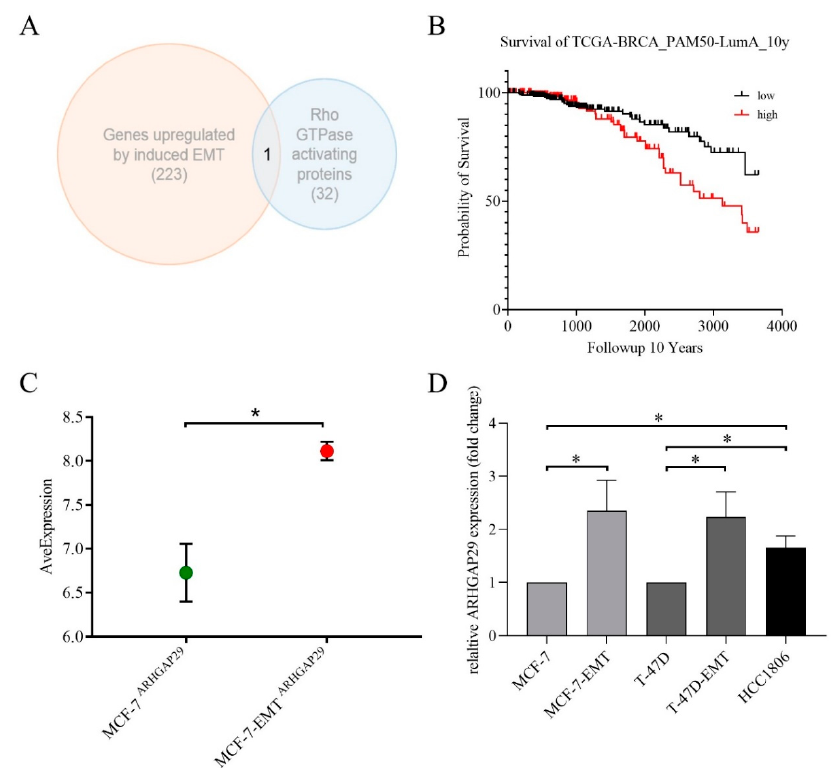
Figure 1. ( A ) Schematic representation of the overlap of microarray data of 223 genes upregulated by induced epithelial–mesenchymal transition (EMT) and 32 considered Rho GTPase-activating proteins. Microarray data from Ziegler et al. [22] were re-analyzed to show the upregulated expression of selected genes. Gene expression data of MCF-7 wild-type cells and mesenchymal-transformed MCF-7-EMT cells were compared. Among the genes examined were 32 genes that had previously been recognized as Rho GTPase-activating proteins. EMT-induced upregulation in MCF-7-EMT cells was found in 223 genes in comparison to MCF-7 wild-type cells. Only the Rho GTPase-activating protein 29 (ARHGAP29) was found to overlap. The relative change in expression (FC, fold change) of genes under consideration was 1.0–4.53. ( B ) Kaplan-Meier survival analysis of the luminal A breast cancer subtype (Threshold = 8 FPKM; ARHGAP29 low n = 271; ARHGAP29 high n = 209; Statistical test: Log-rank (Mantel-Cox) test; p = 0.0141). ( C ) Evidence of the significantly increased basal expression of ARHGAP29 in MCF-7-EMT cells was found. Basal expression (average expression) of ARHGAP29 in the cell lines MCF-7- and MCF-7-EMT was found. Microarray data from Ziegler et al., 2014 comparing the gene expression of MCF-7 wild-type cells and mesenchymal-transformed MCF-7-EMT cells were examined to investigate ARHGAP29 gene expression. ( D ) Expression of ARHGAP29 in MCF-7, MCF-7-EMT, T-47D, T-47D-EMT, and HCC1806 breast cancer cells. Expression of ARHGAP29 was analyzed by quantitative real-time PCR and normalized to GAPDH expression using at least three biological and technical replicates. Mean ± SEM values are given. Significance was determined with the help of unpaired t-tests; (*) p < 0.05.